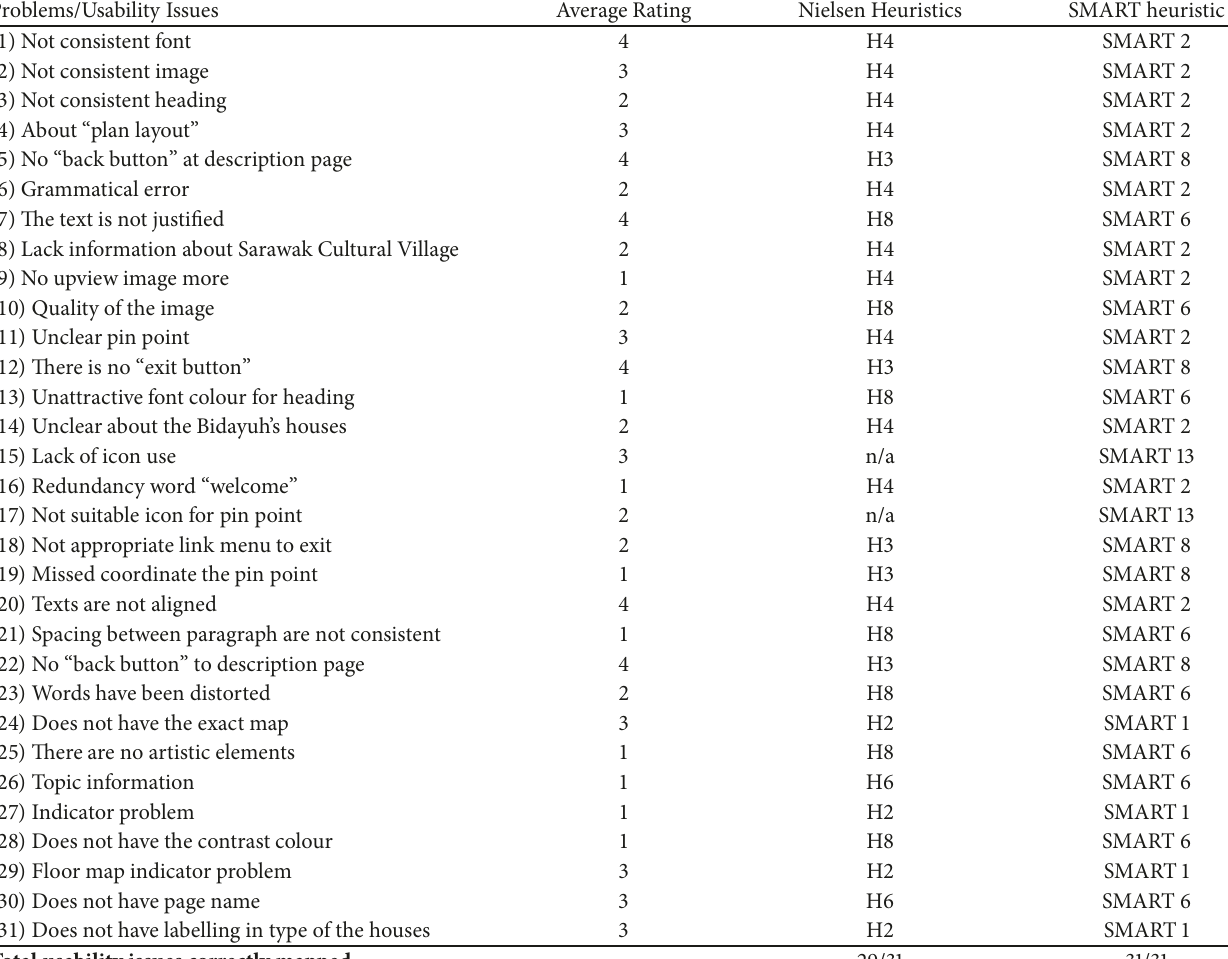
Table 3: Usability issues, average severity, and its mapping with Nielsen’s Heuristic and SMART